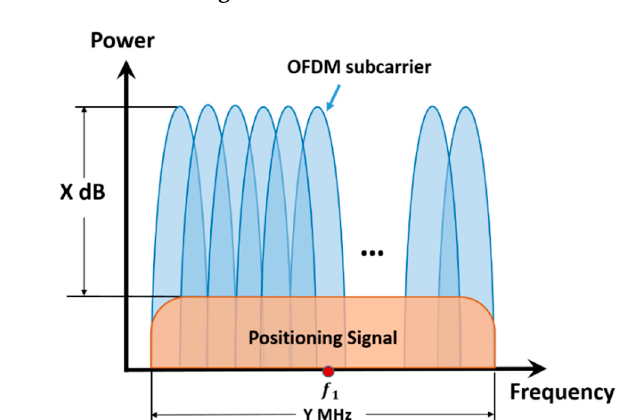
Figure 1. Structure of FSBS.